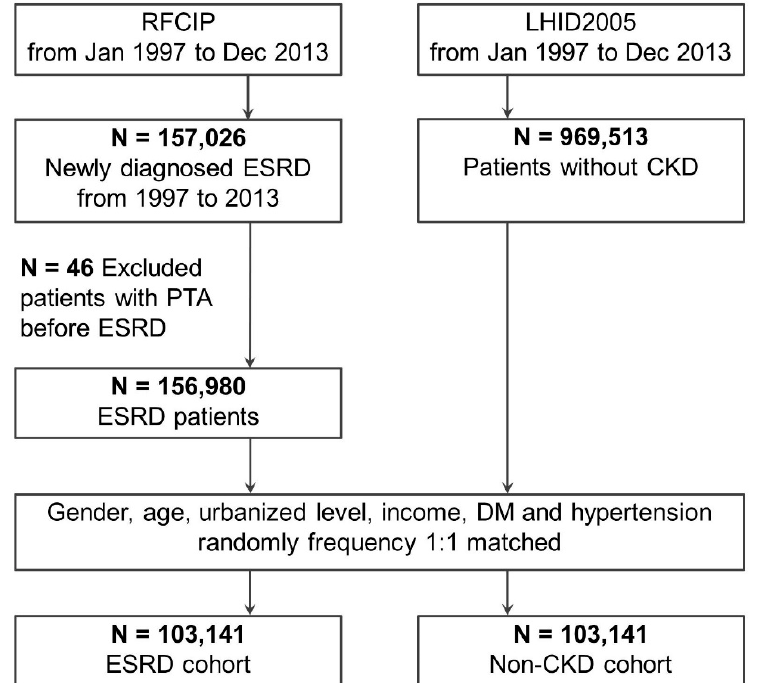
Figure 1. Flow of study and comparison cohort enrollment. Abbreviations: CKD, chronic kidney disease; DM, diabetes mellitus; ESRD, end-stage renal disease; LHID2005, Longitudinal Health Insurance Database 2005; RFCIP, Registry of Catastrophic Illness Patients; PTA, peritonsillar abscess